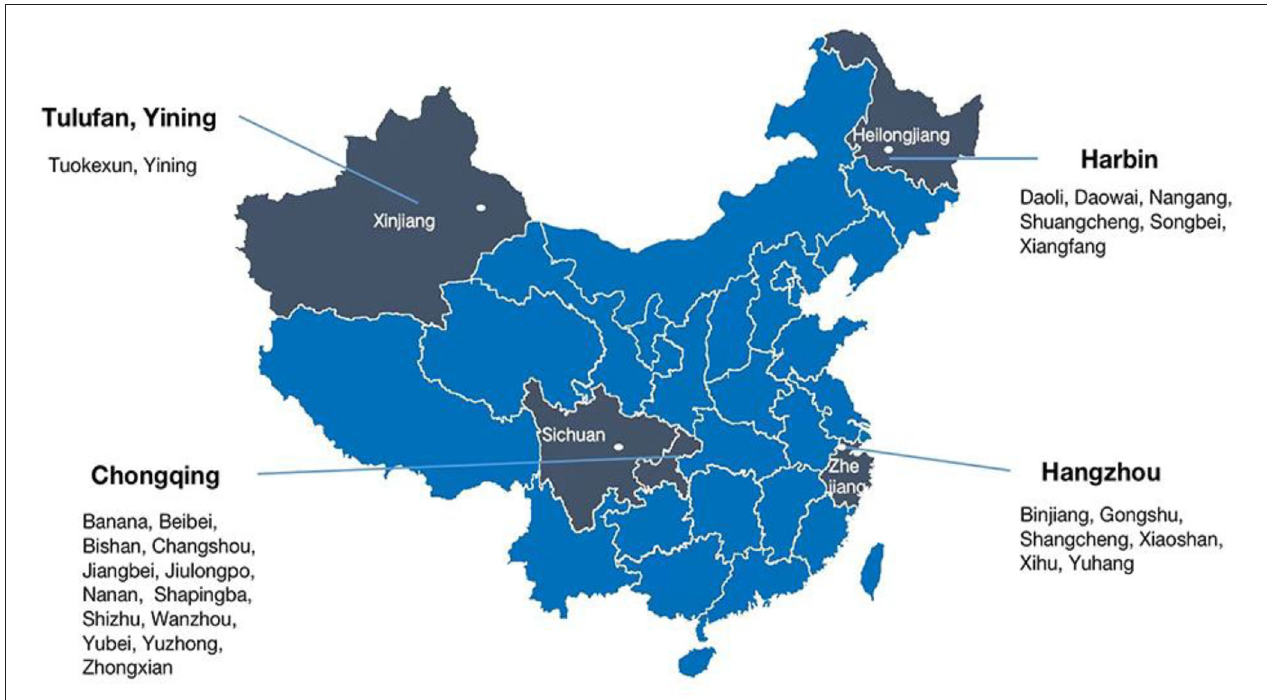
FIGURE 1 | Sampling designs in the